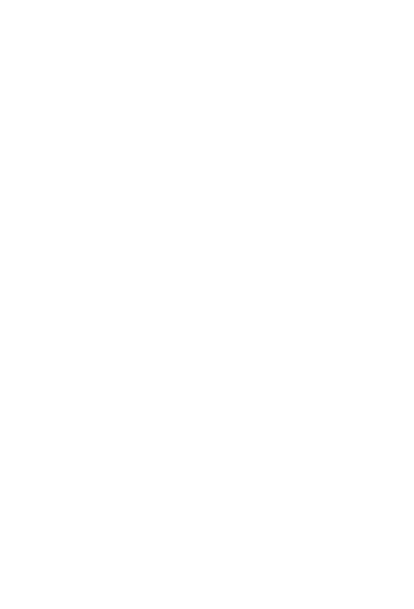
Figure 3. Schematic view of MLG nucleation model is explained in four